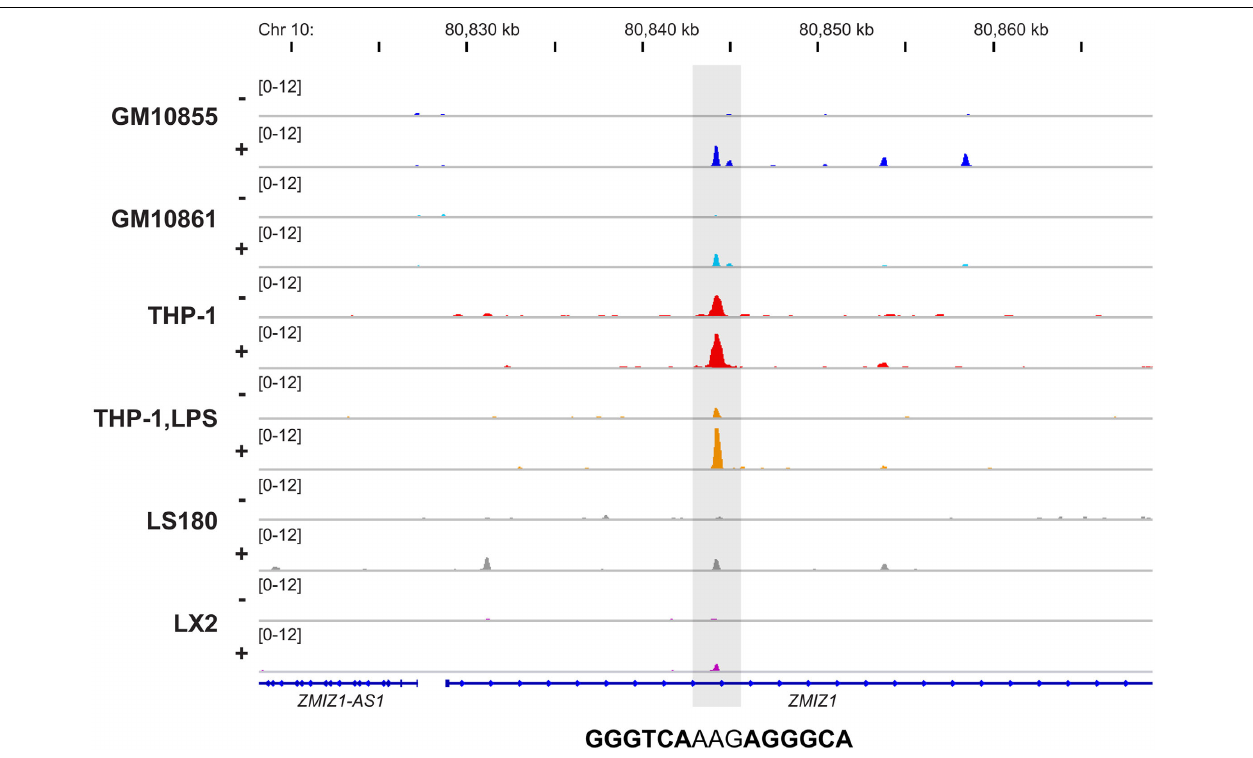
FIGURE 1 | Conserved genomic VDR binding in six cellular models. The Integrative Genomics Viewer (IGV) browser (Robinson et al., 2011) was used to visualize the VDR binding site 15.3kb downstream of the ZMIZ1 TSS. The peak tracks display data from VDR ChIP-seq datasets from two B cell-like cells (dark and light